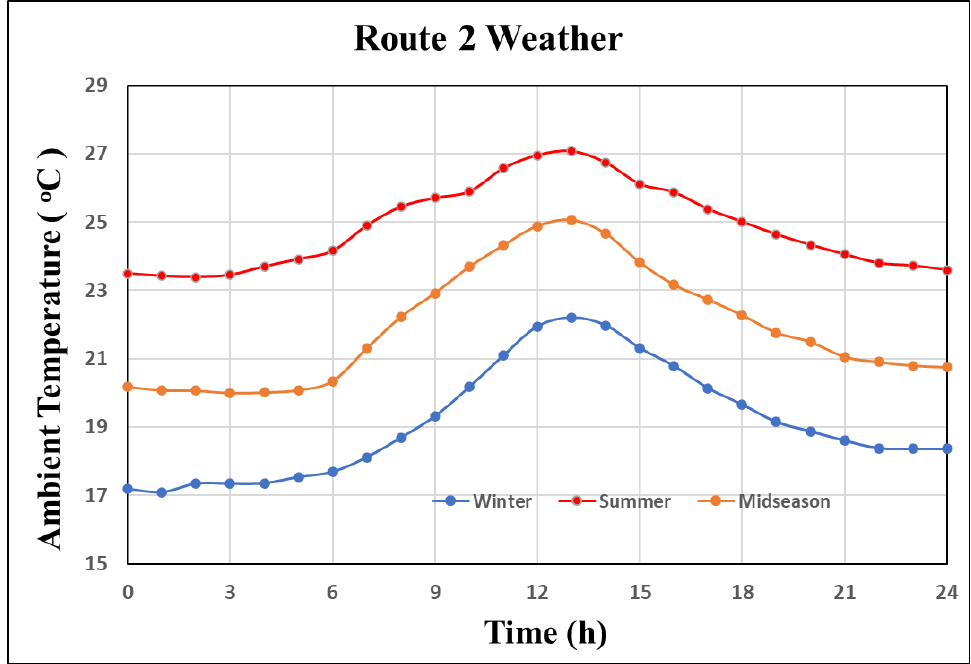
Figure 5. Ambient temperature of all seasons for the second journey from Shanghai, China, to Ham- burg, Germany. Hamburg,